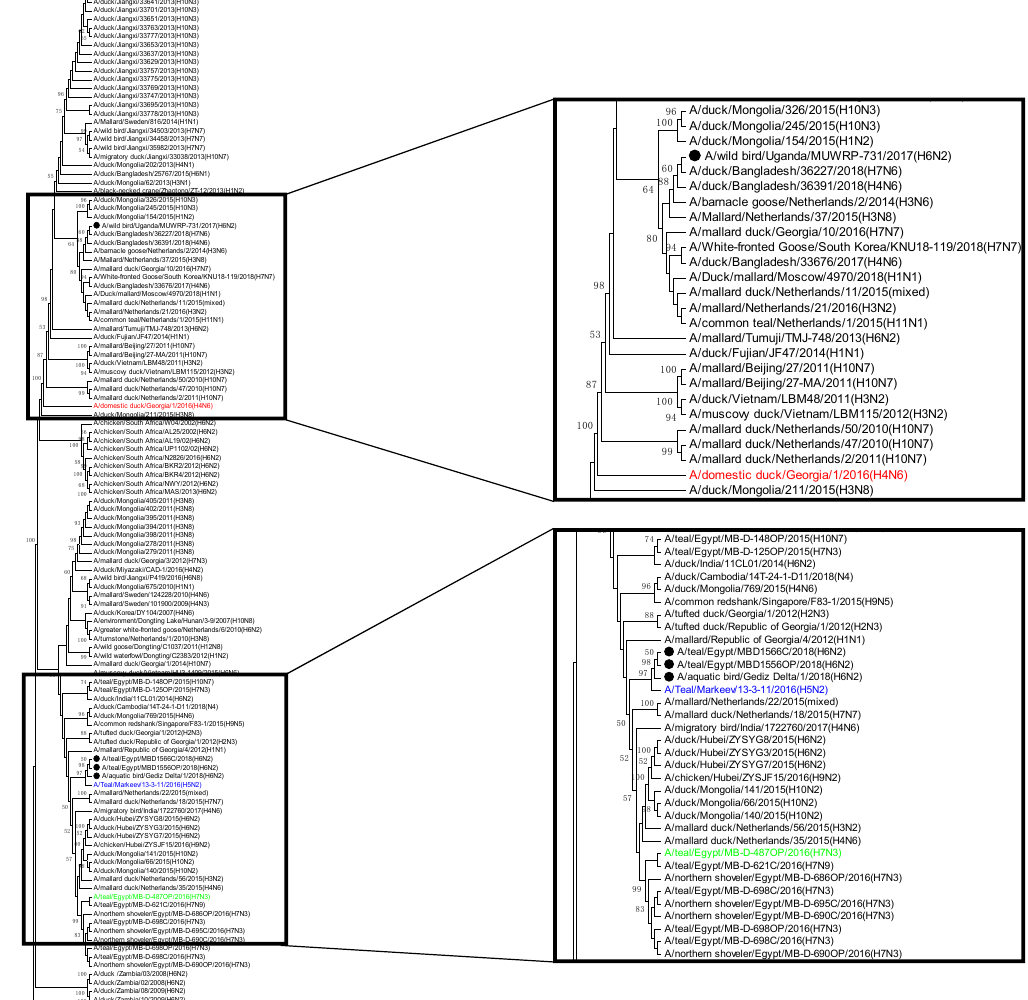
Figure 2. Phylogenetic relationships between the PB2 gene of GD/18, EG/1566C, EG/1556OP, and UG/731. Phylogenetic tree was constructed using the Maximum Likelihood method based on the Hasegawa-Kishino-Yano model. All four viruses in this study were indicated with black circles. According to the phylogenetic analysis, the PB2 of GD/18, EG/1566C and EG/1556OP clustered with A/teal/Markeev/13-3-11/2016 (H5N2) (blue). However, the PB2 of UG/731 was genetically closer to that of AIVs circulated in the Netherlands and Bangladesh. Reference viruses (most closely related strains for at least one gene segment) are color-coded: A/domestic duck/Georgia/1/2016 (H4N6) in red, A/Teal/Markeev/13-3-11/2016 (H5N2) in blue, and A/teal/Egypt/MB-D-487OP/2016 (H7N3) in green.